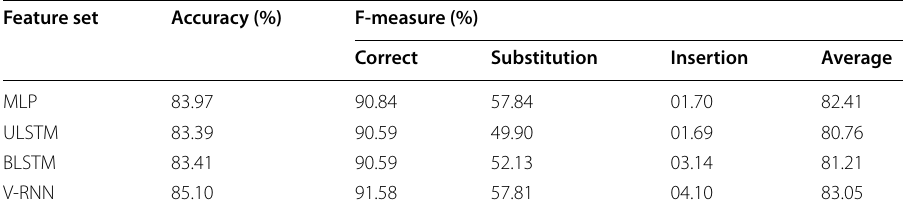
Table 4 Classification accuracies and F-measures of error type classification obtained with the four models trained using the best feature set Feature